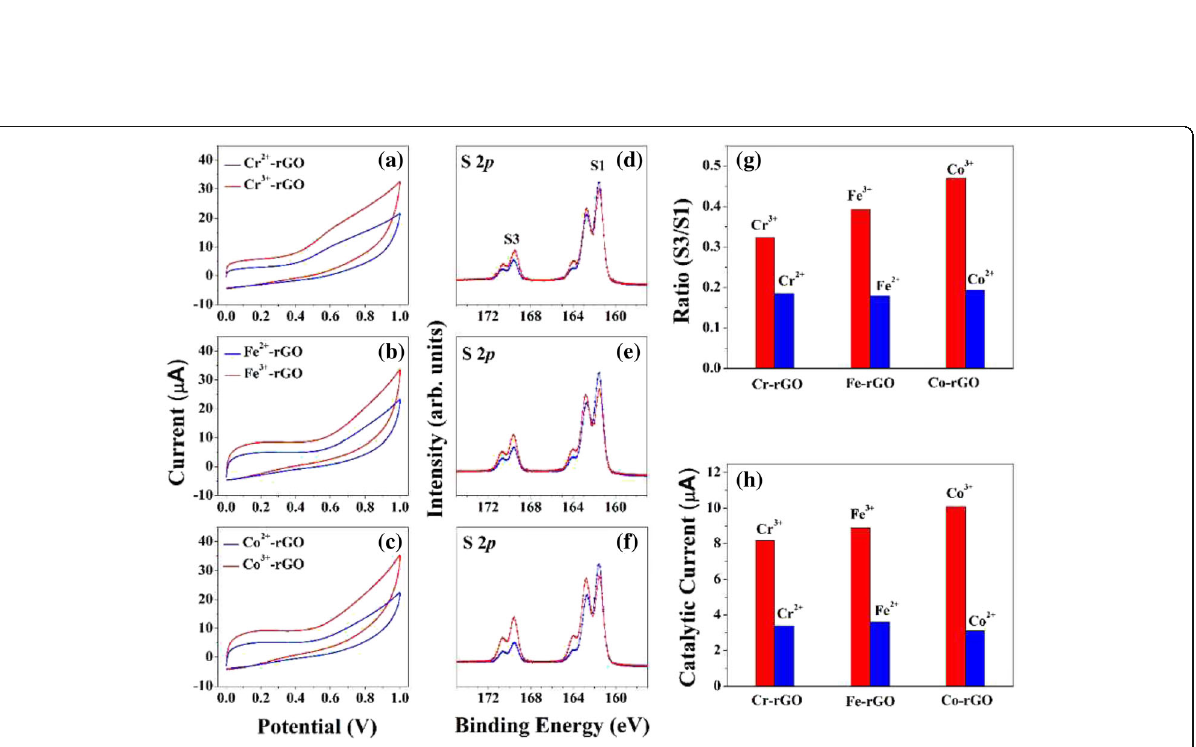
Fig. 4 CV results at a scan rate of 50 mV/s for 0.015 M Cys solutions in PBS at GCEs modified with 5 wt% a Cr-rGO, b Fe-rGO, and c Co-rGO. HRPES S 2 p core-level spectra of the products of the photocatalytic oxidations of Cys (after 180 L exposure) carried out in the presence ( red lines : TM 3+ and blue lines : TM 2+ ) of 5 wt % d Cr-rGO, e Fe-rGO, and f Co-rGO. g Values of the S3-to-S1 ratio after 180 L Cys exposure. h Catalytic currents resulting from the electrochemical oxidations of Cys in the presence of the various types of pristine rGO and the three TM-rGO ( red lines : TM 3+ and blue lines : TM 2+